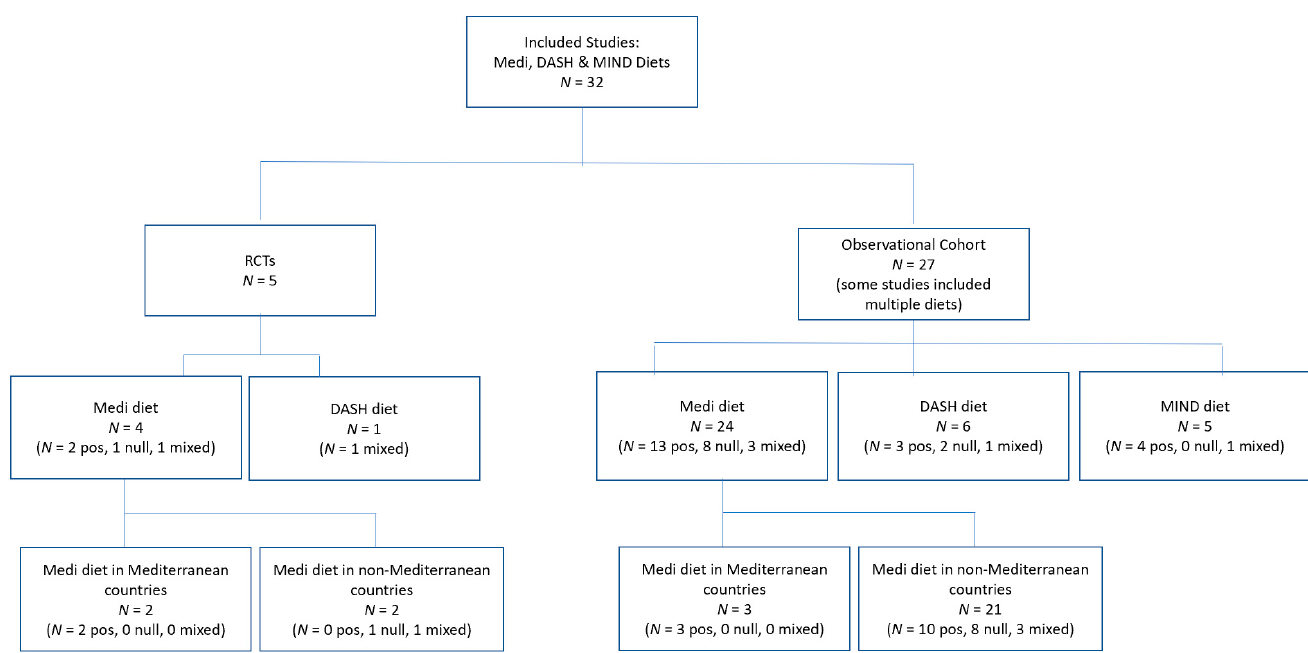
Figure 1. Overview of included studies.